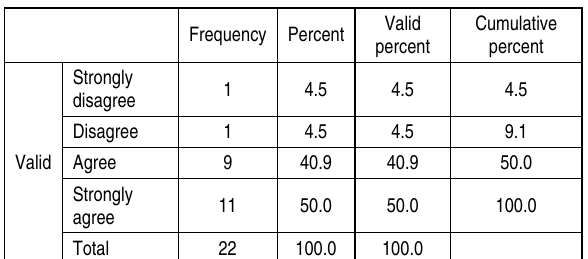
Table 1. Intellectual challenge of the SBIC project